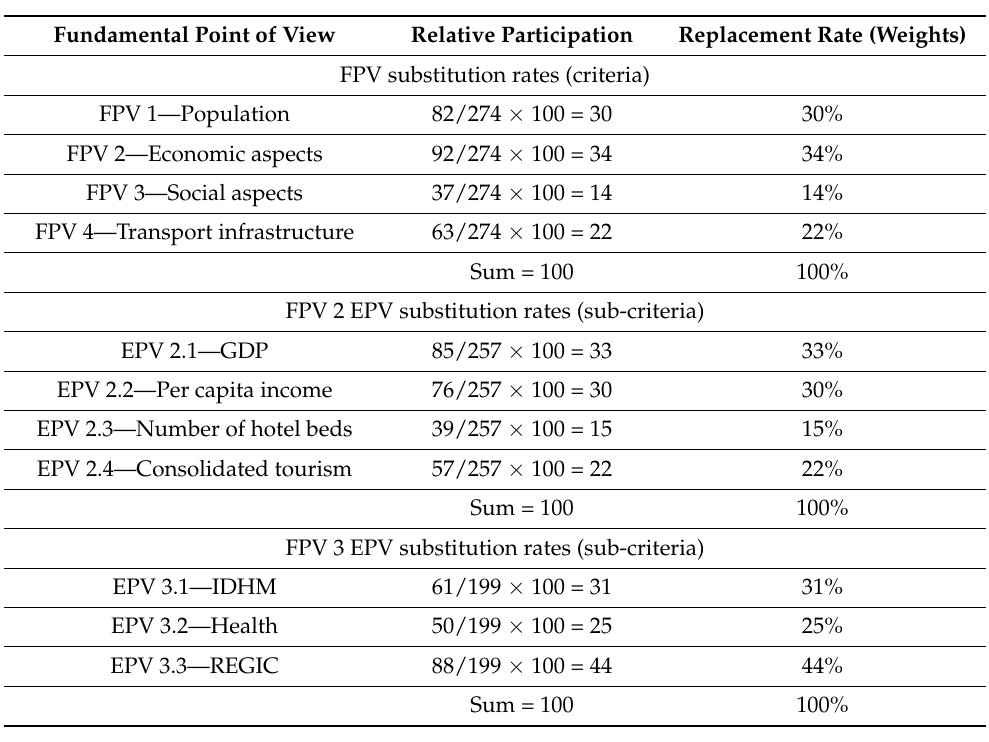
Table 8. Relative participation of each PVF and